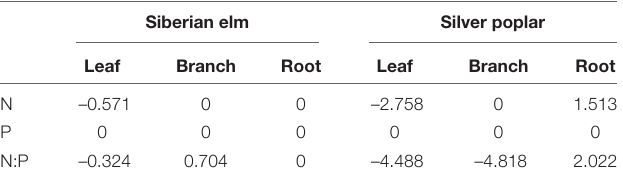
TABLE 3 | Regression slopes (1/ H ) of relationships between plant and soil nutrient stoichiometry of Siberian elm and Silver poplar. Siberian